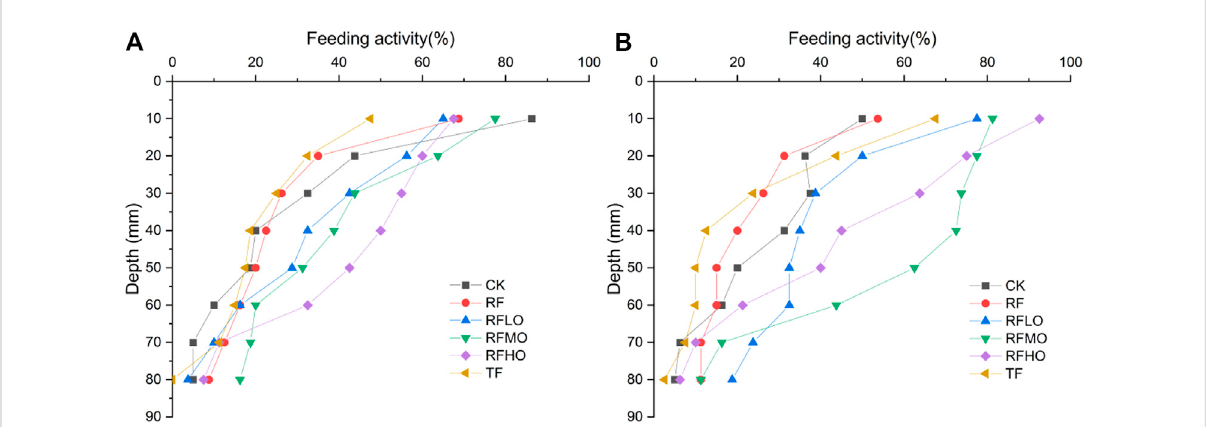
FIGURE 4 Depth pro fi les of the feeding activities (%) in the six fertilization management practices were determined by the bait-lamina test ( n = 150 bait laminae) after 15 days of exposure in September 2019 (A) , and 2020 (B) .